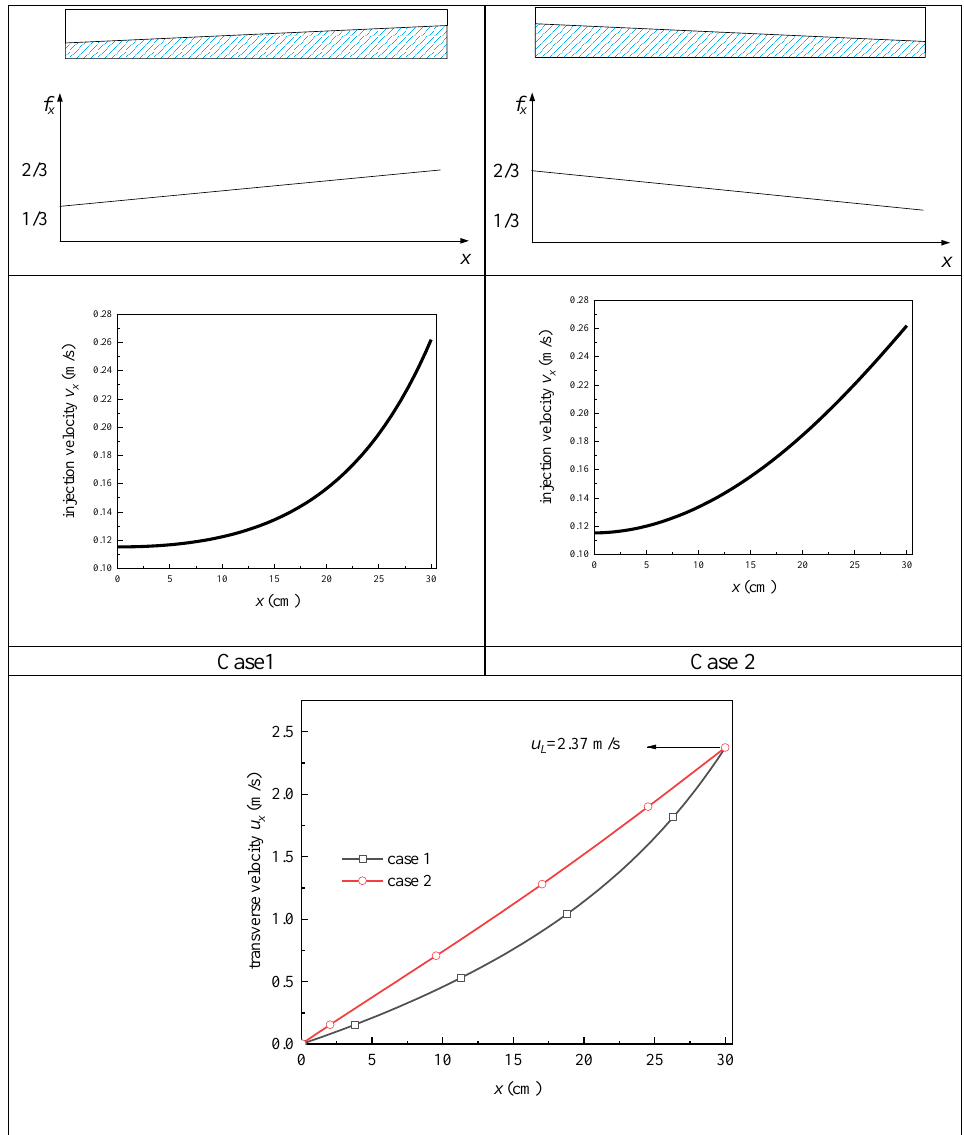
Figure 9. Comparison of cases with a series of bubbles at different positions.